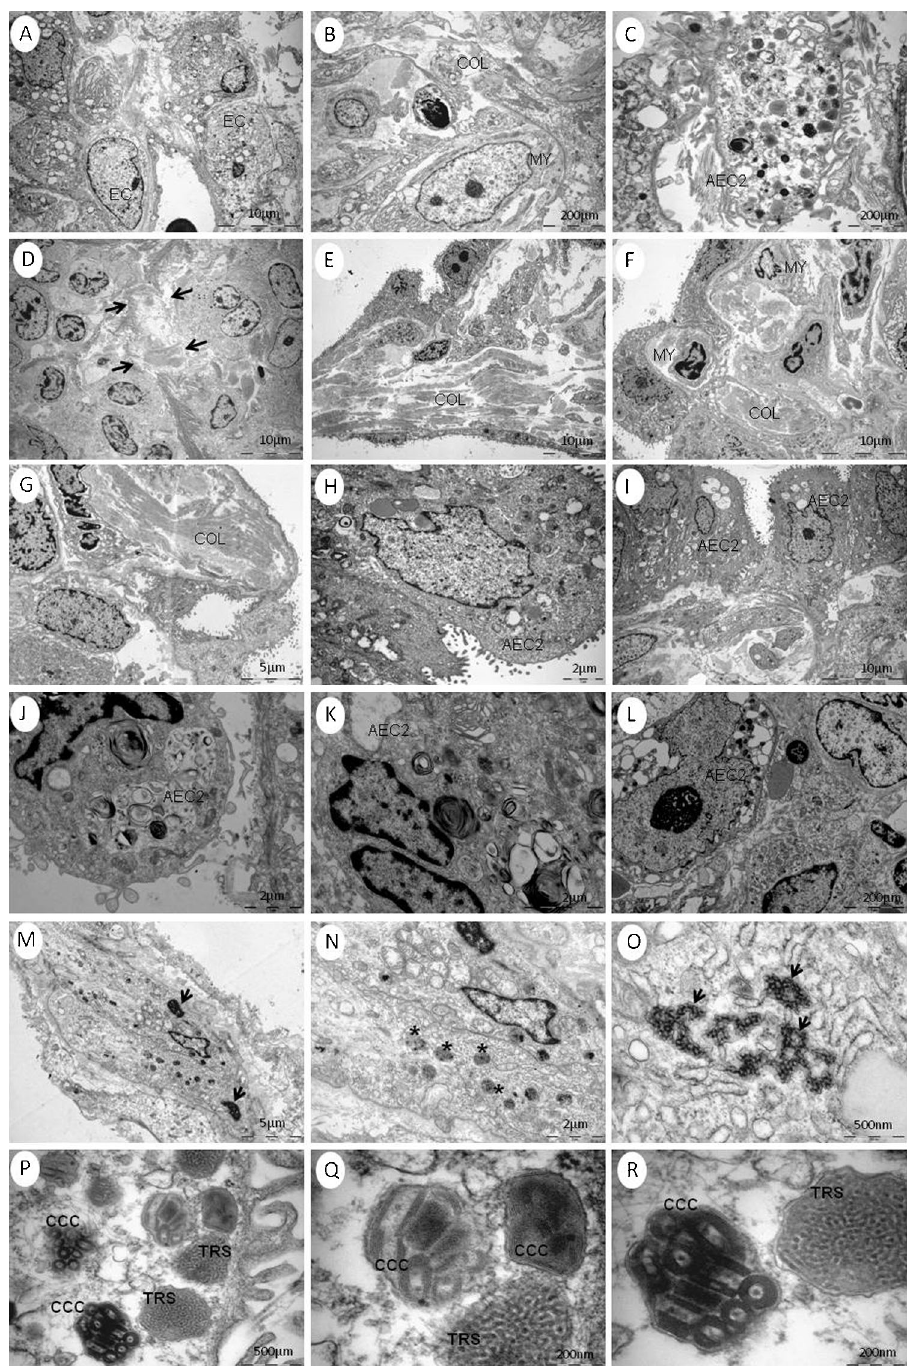
Figure 2 - Ultrastructure sections of lungs from N1H1 patients. Large number of bronchial (EC) and alveolar epithelial cells (AEC2) in apoptosis, note markedly condensed chromatin close to the nuclear membrane (A to C). In panel D, denudation of the epithelial basement membrane and fibrin deposition (arrows). In alveoli, the hyaline membranes appear homogeneous and extend along and partially cover the denuded epithelial basement membranes (D). Regeneration of epithelial cells is shown in panel E to I: note the cells with prominent surface microvilli with decreased or absent lamellar bodies and considerable cytologic atypia. Myofibroblasts (MY) and collagen fibers (COL) were also present (E,F,G). Multinucleated epithelial cells (J,K,L) showing tubuloreticular structures (TRS) and cylindrical confronting cisternae (CCC) representing viral-like particles residuals are shown in M (arrow head), N (star), O (arrow head). TRS showing reticular aggregates of branching membranous tubules located within the cisternae of the endoplasmic reticulum (P,Q,R). Cylindrical confronting cisternae (CCC) showing long cylinders of fused membranous lamellae (M to R), (Uranile and lead